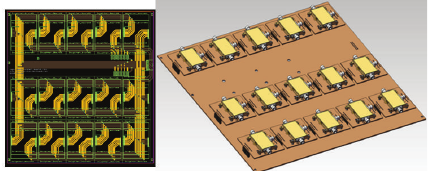
Figure 5: Photo of the fabricated MFPA (chip size: 2.5 mm × 1.4mm).